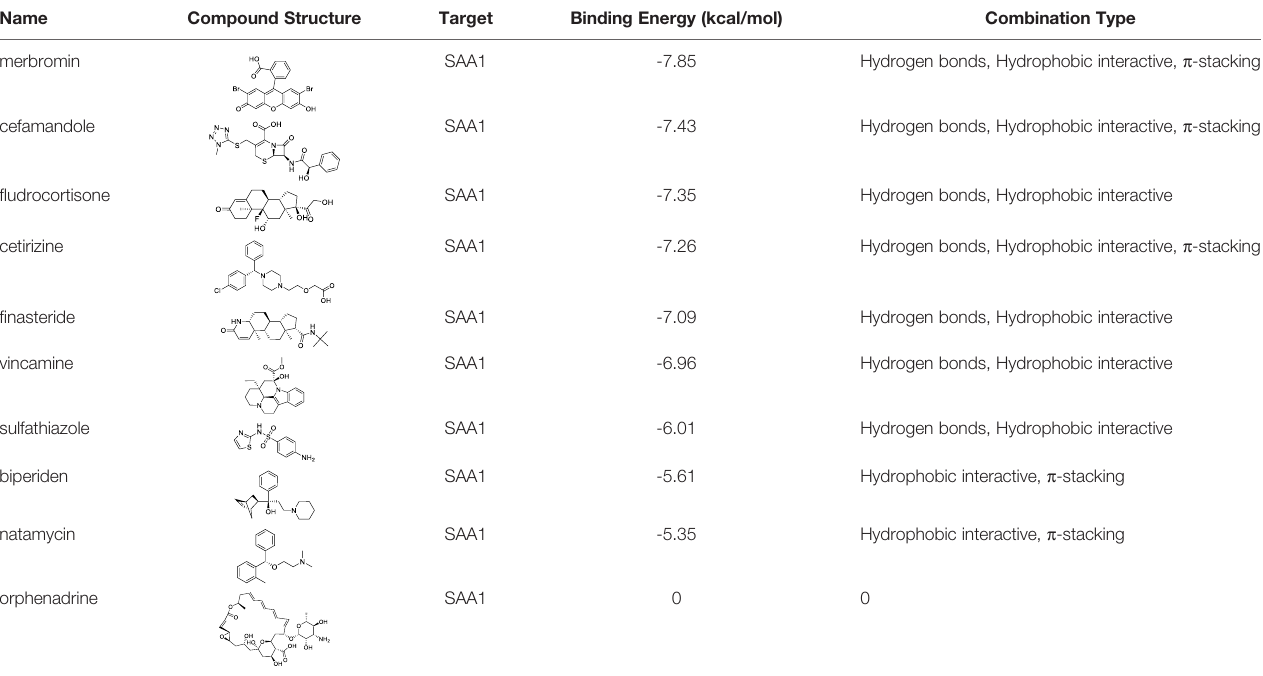
TABLE 4 | The selected compounds of docking